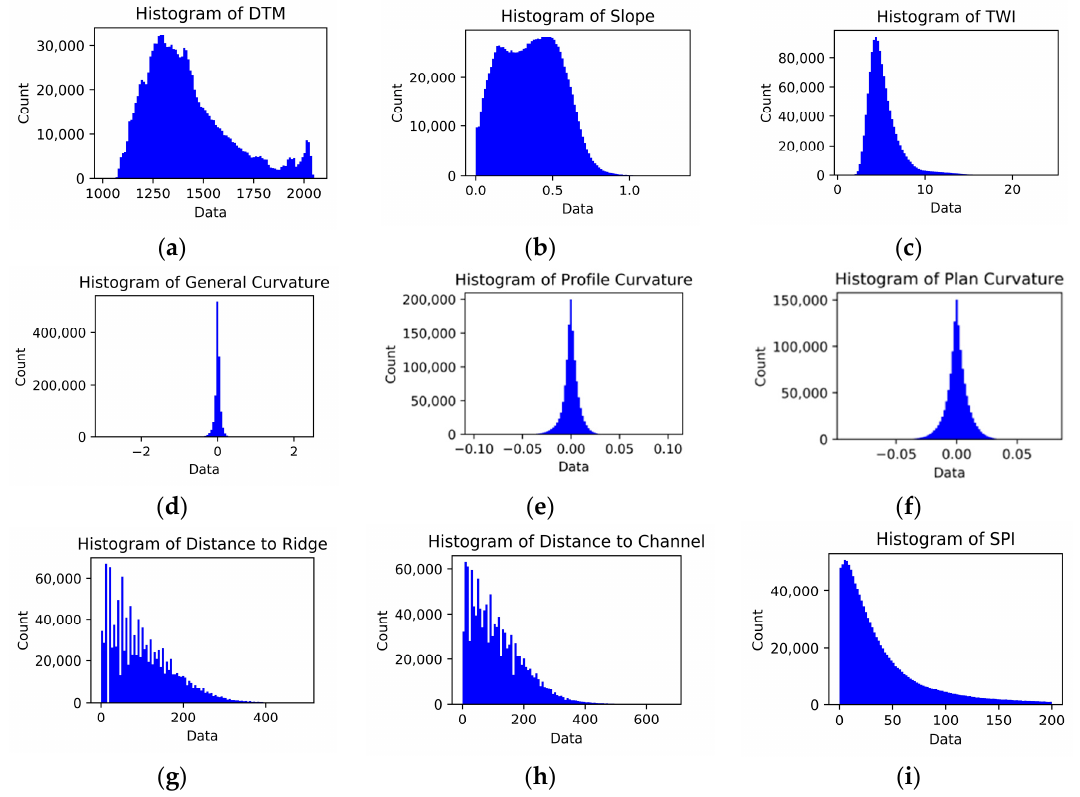
Figure 7. Histograms of topographical parameters derived from 2012 DTM.